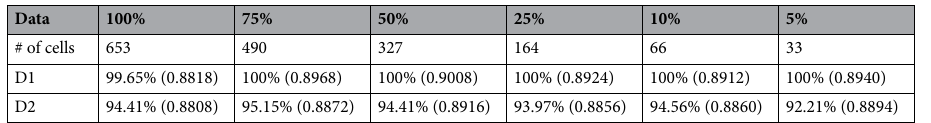
Table 2. Percentage of matched cells and average DICE coefficient of ANMAF models trained on synthetic images generated using a different number of neurons in datasets D1 and D2. Parentheses represent the average DICE coefficients between manual and model-generated contours of matched somatic